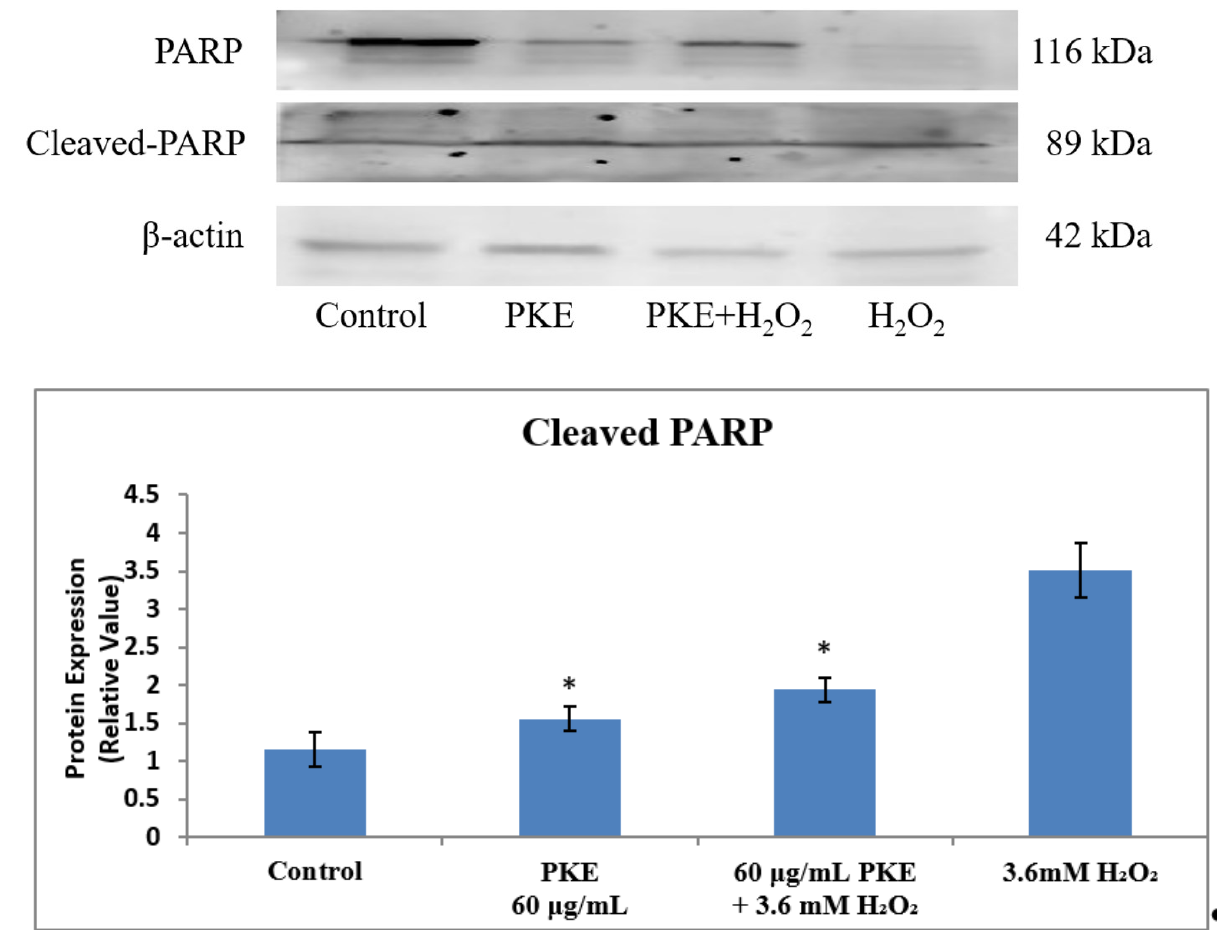
Figure 7. The cleaved PARP in the western blot assay after cells were treated with PKE extract (60 μg/mL), PKE (60 μg/mL) with 3.6 mM added H 2 O 2 , and 3.6 mM H 2 O 2 for 24 h. Values are expressed as mean ± SD ( n = 3), * p < 0.05 for compared with control group.